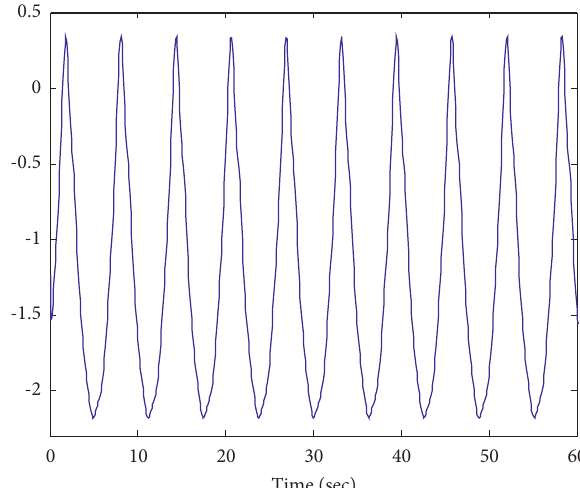
Figure 9: Trajectories of tracking errors between Y